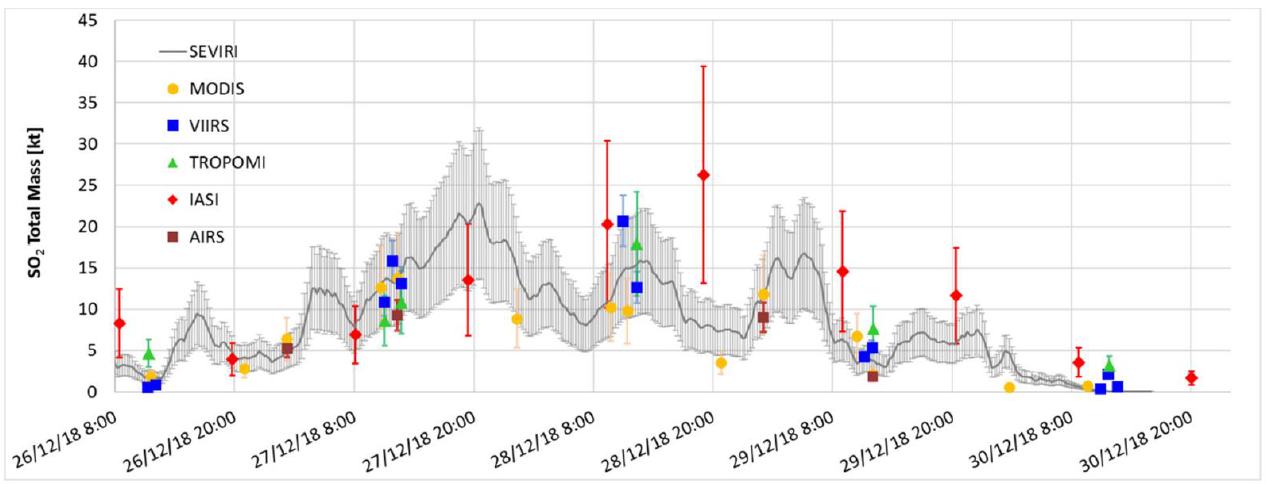
Figure 7. SO 2 total masses computed from the images collected by the different satellite instruments in the latitude–longitude grid 34–38N, 14–18E.